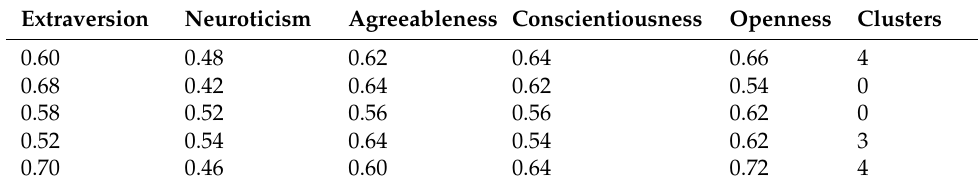
Table 1. Results of PCA.